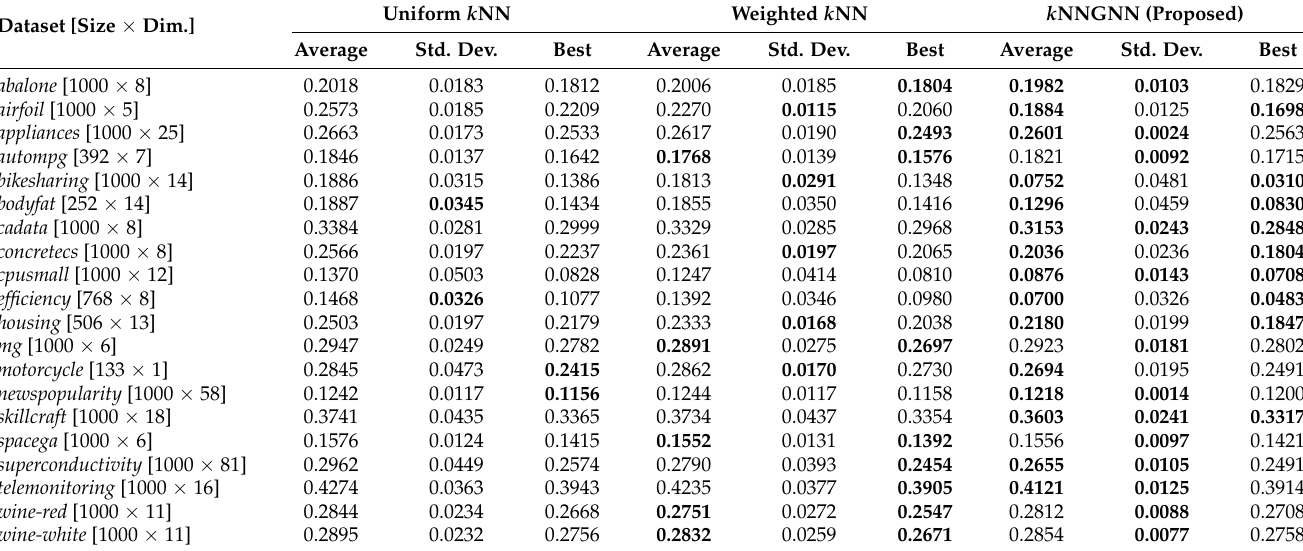
Table 2. Summary statistics of the RMSE over different hyperparameter settings on the regression datasets. Dataset [Size ×